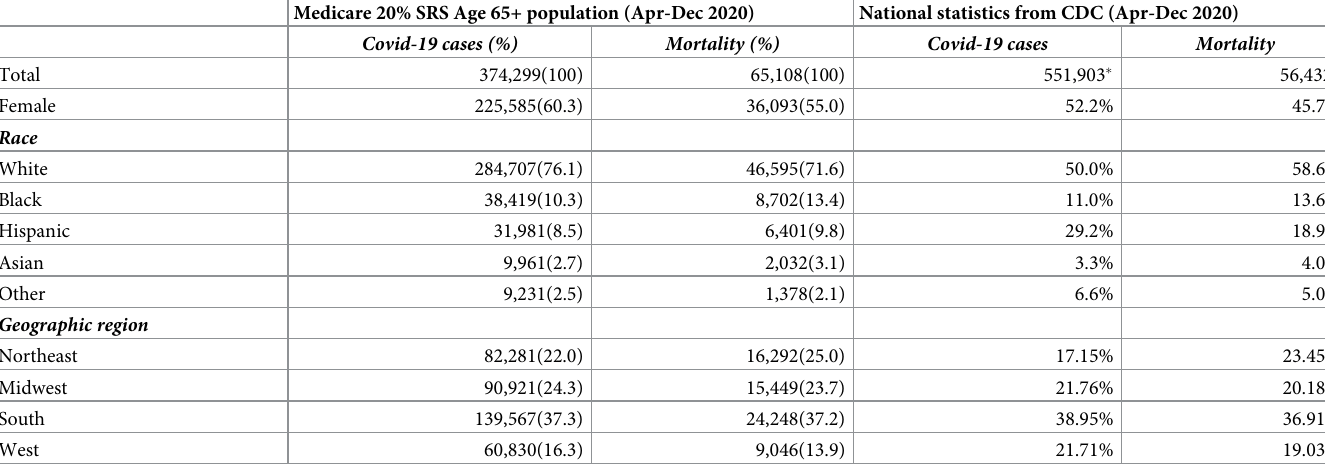
Table 1. Study population compared to U.S. national statistics, April to December 2020 (SRS—Simple random sample; CDC—Centers for Disease Control and